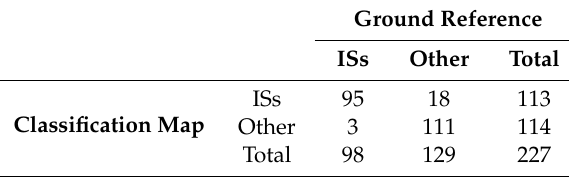
Table 4. Out-of-bag (OOB) confusion matrix for the random forests classifier. Observations ISs Other Total ISs 3860 Predictions